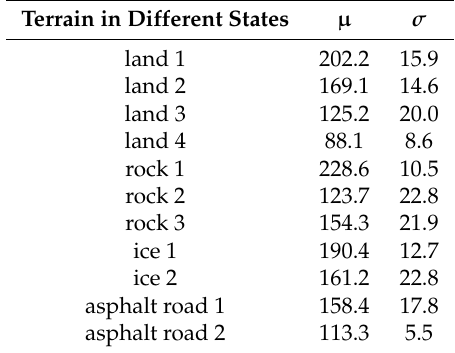
Table 1. Means and variances of optical